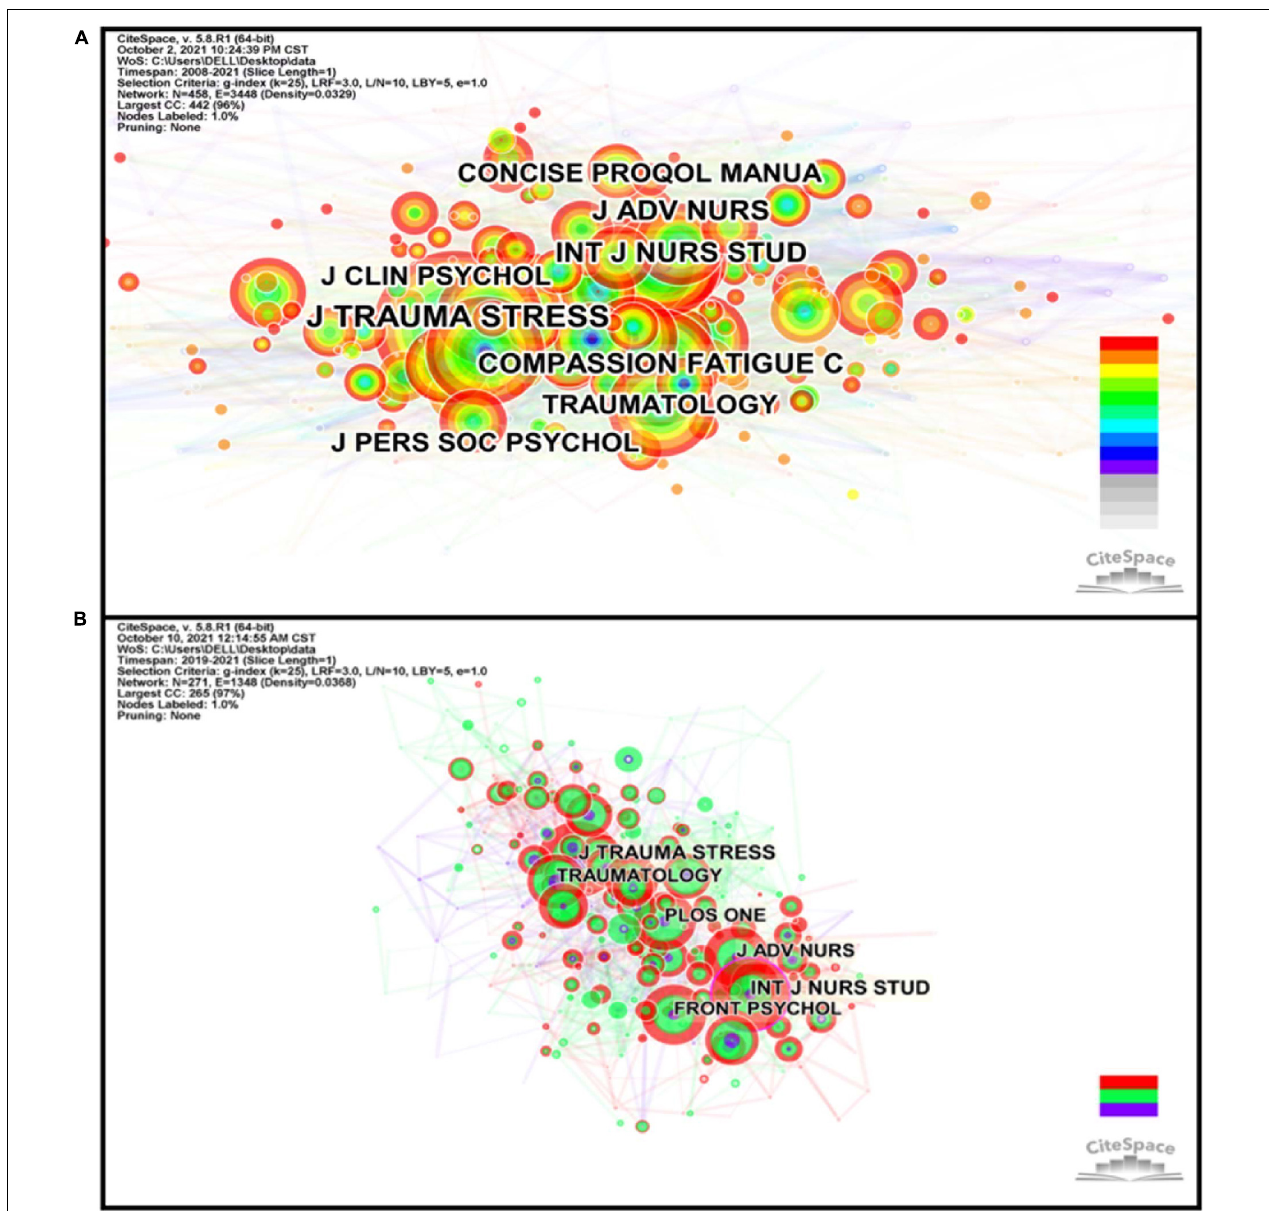
FIGURE 6 | The network visualization map of journal co-citation analysis during 2008–2021 (A) and the COVID-19 pandemic (B) . The individual circle indicates a journal, and its size was weighted by the number of cited journals. The individual link between two circles meant co-citation relationships, and its thickness was weighted by the frequency of collaborations. The purple rims of circles indicate high betweenness